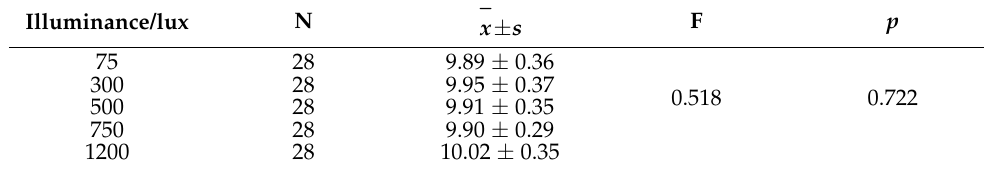
Table 11. Task stage P lt One-way ANOVA